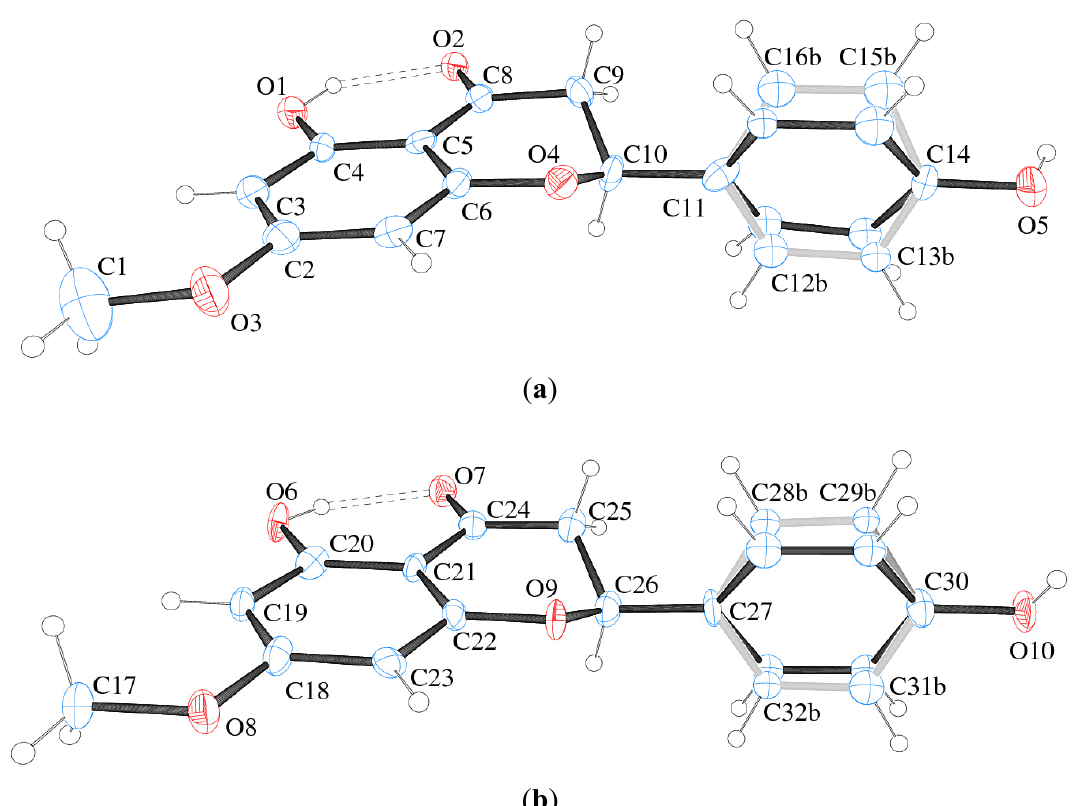
Figure 2. ORTEP plot and atom numbering of ( a ) molecule A and ( b ) molecule B of sakuranetin-monohydrate (S-enantiomer arbitrary chosen). Ellipsoids represent 50%-probability level. Double-dotted lines represent intramolecular H-bond. Disorder in the rings is detailed in light grey and black. Water molecules were omitted for